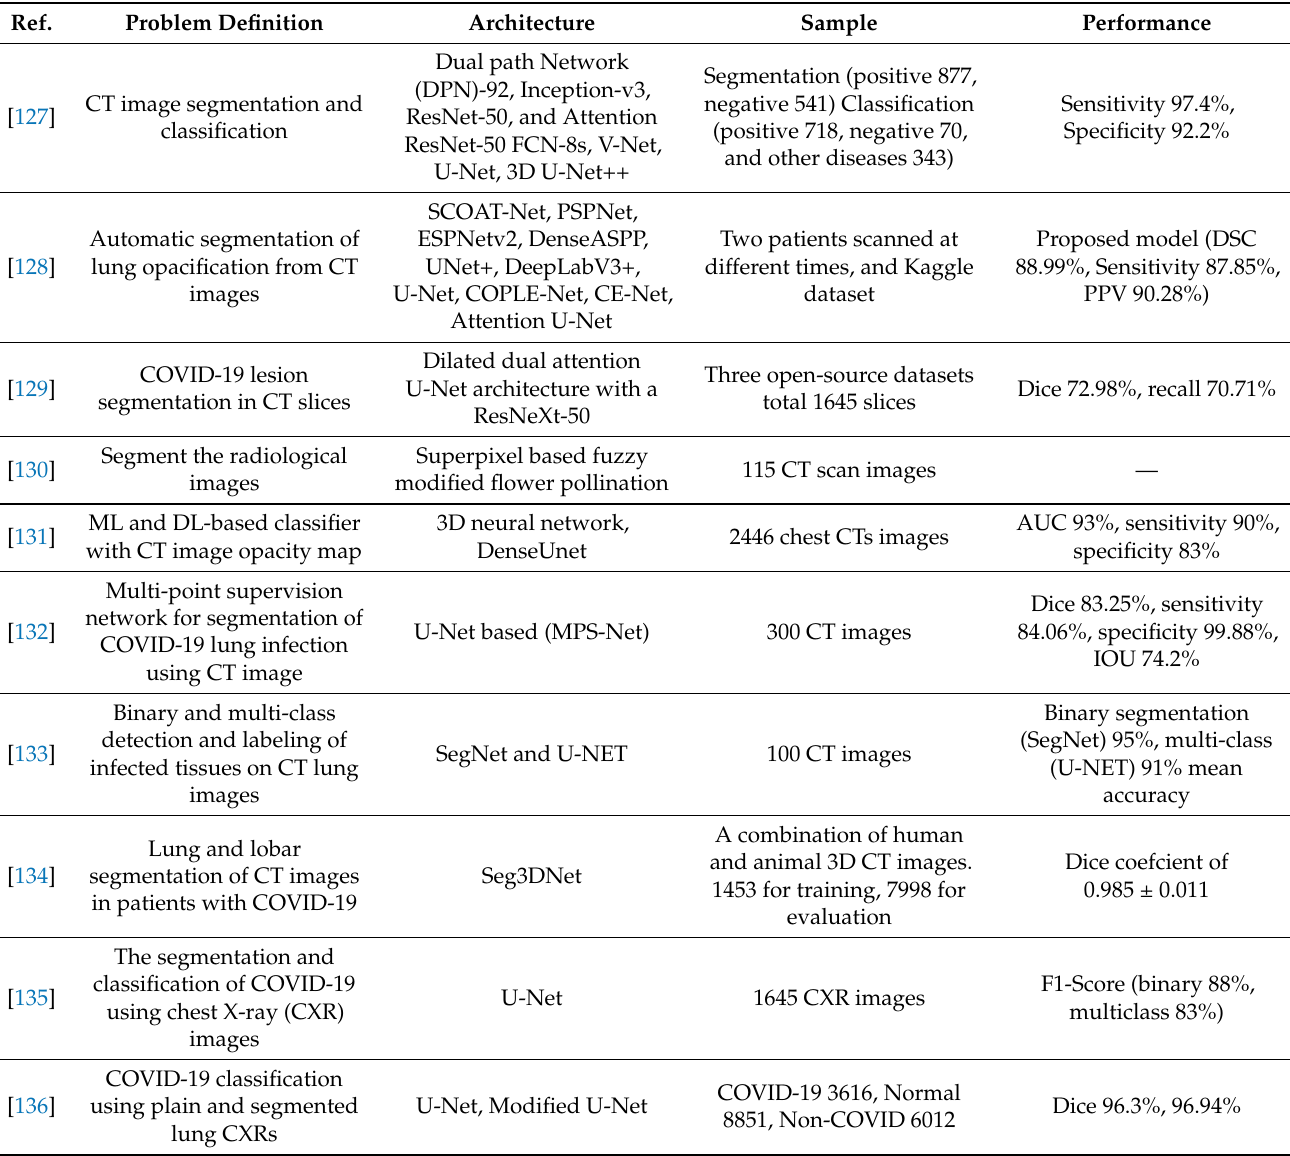
Table 4. Review of image segmentation applied applications for